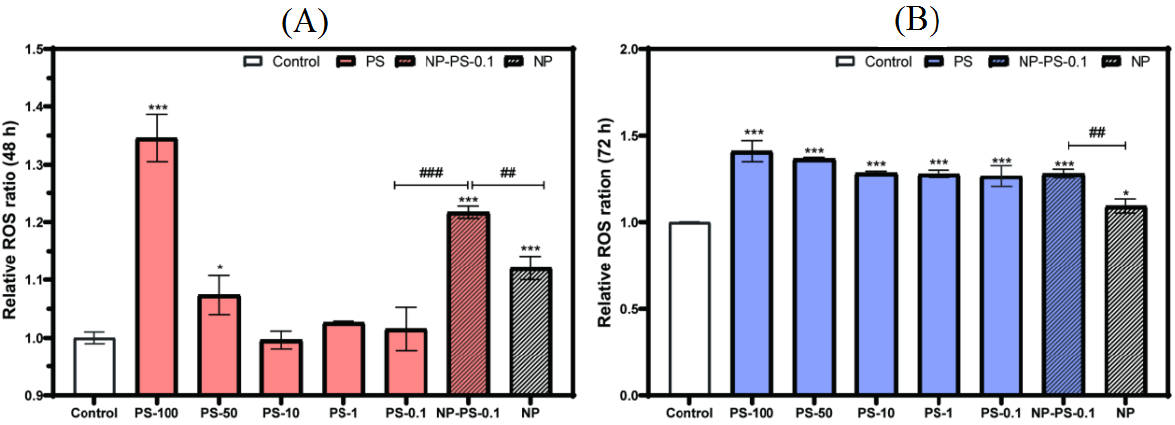
Figure 7. Effects of PS-MPs and NP on the generation of the intracellular ROS of Caco-2 cells at 48 ( A ) and 72 h ( B ), expressed as a ratio to the control group. * indicates the significant difference between the treatment group and the control group (* p < 0.05, *** p < 0.0005). # indicates the significant difference between the marked groups ( ## p < 0.001, ### p < 0.0005).